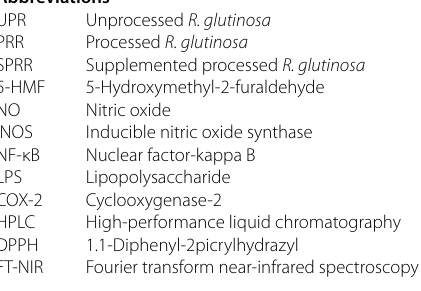
Additional file 1: Figure S1. Certificate of analysis of optimized pro- cessed R. glutinosa (SPRR 20% EtOH) accredited by Korea ministry of Food and Drug Safety.